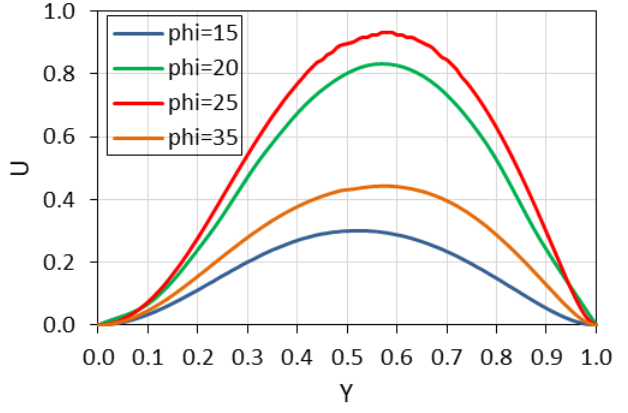
Fig. 5. Velocity along the centerline at X= 0.5L of the roof pitch angles.